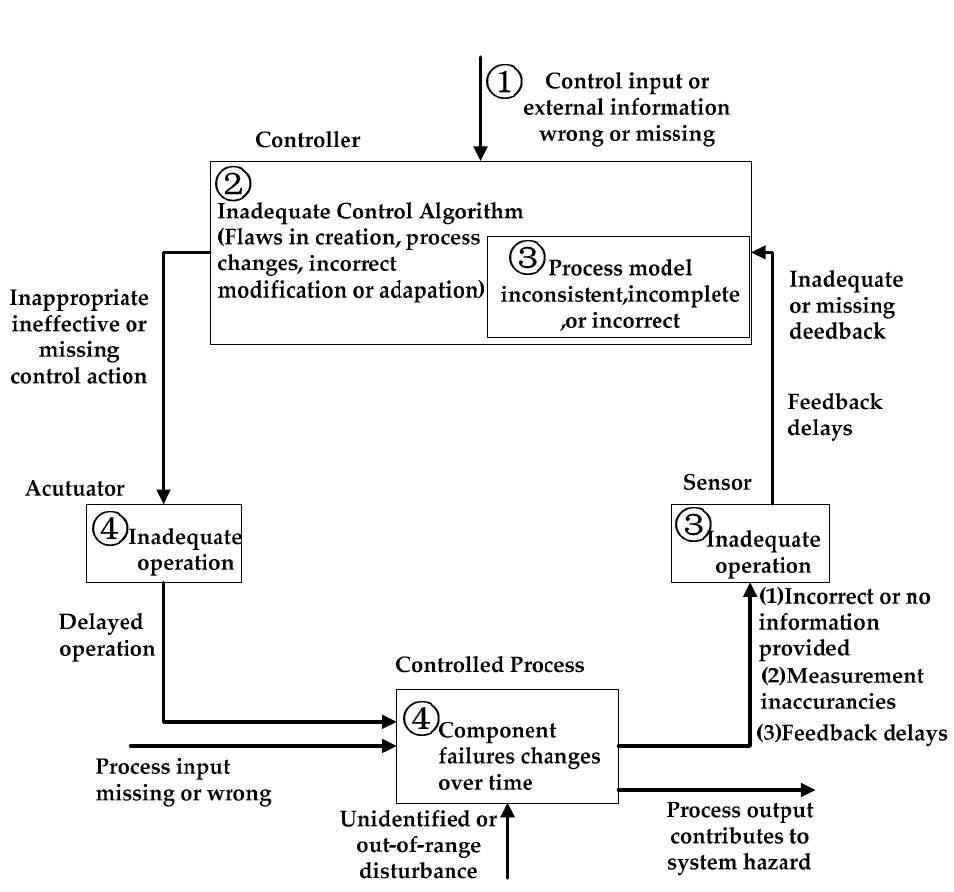
Figure 5. Basic causes of unsafe control. Reproduced with permission from [15], Elsevier,